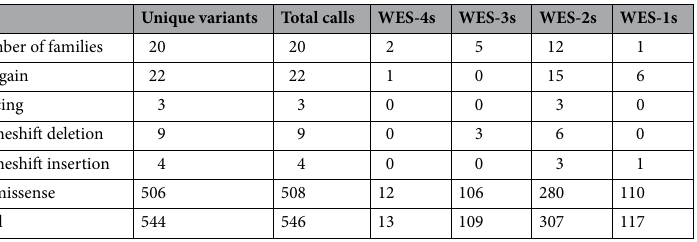
Table 2. Overview of risk variants with MMAF < 0.01, CADD > 20 and shared by all family members. WES-4s: families with 4 sequenced individuals; WES-3s: families with 3 sequenced individuals; WES-2s: families with 2 sequenced individuals; WES-1s: families with 1 sequenced